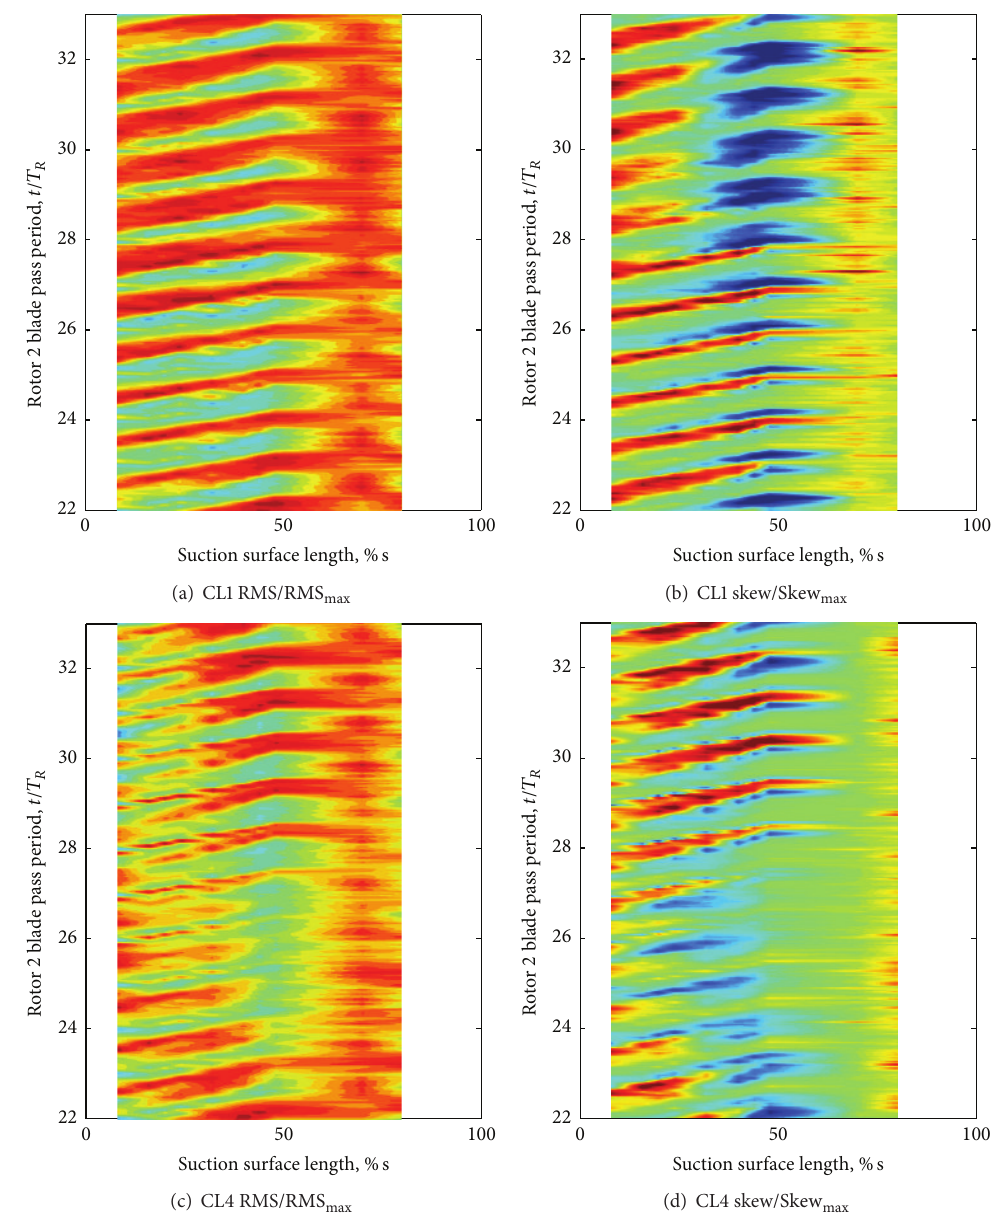
Figure 11: RMS (a, c) and skew (b, d) of Stator 2 QWSS for two clocking configurations at 75% span for 33% SM.